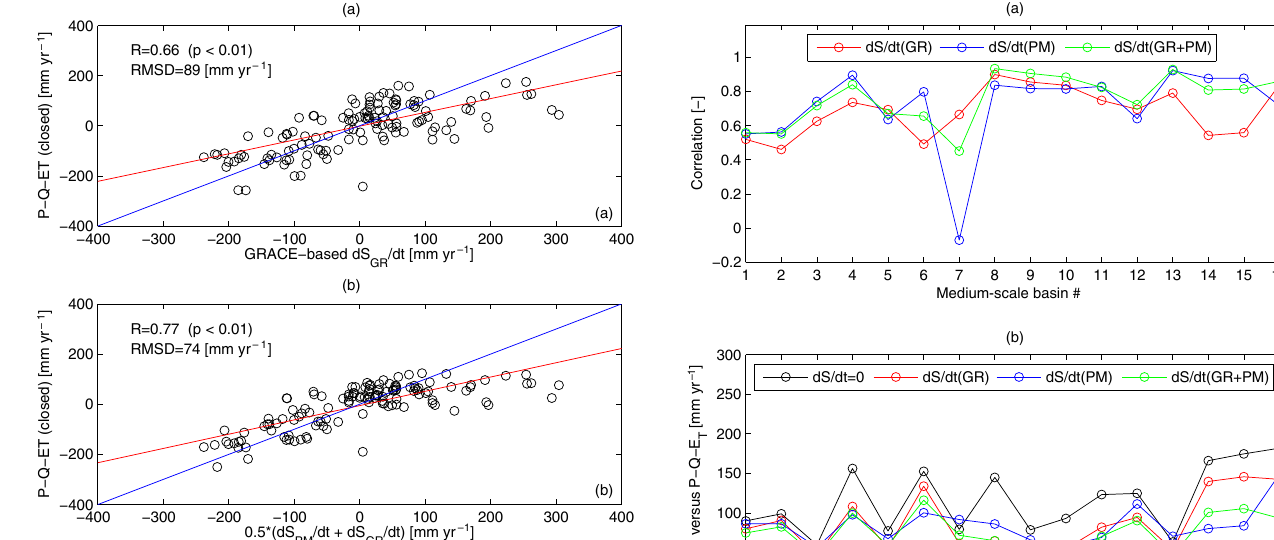
Figure 8. (a) Relationship between annual P − Q − E T (with 8- year closure) and gravity-based d S GR / d t estimates within each of the 16 medium-scale basins listed in Table 1. Part (b) is the same as (a) except for correlation against the simple average of d S PM / d t and d S GR / d t . The blue line is a one-to-one line and red line is the least-squares linear fit.